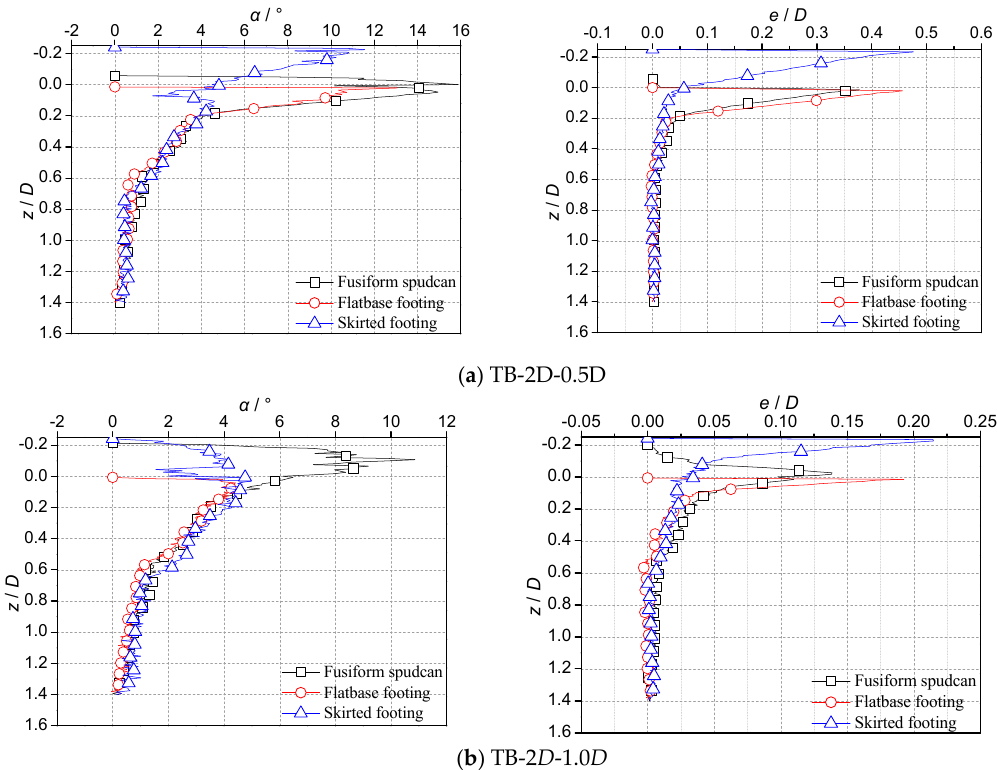
Figure 21. Variations in the ( a ) load inclination and ( b ) load eccentricity during the reinstallation process of the β = 0.5 D , 1.0 D cases.